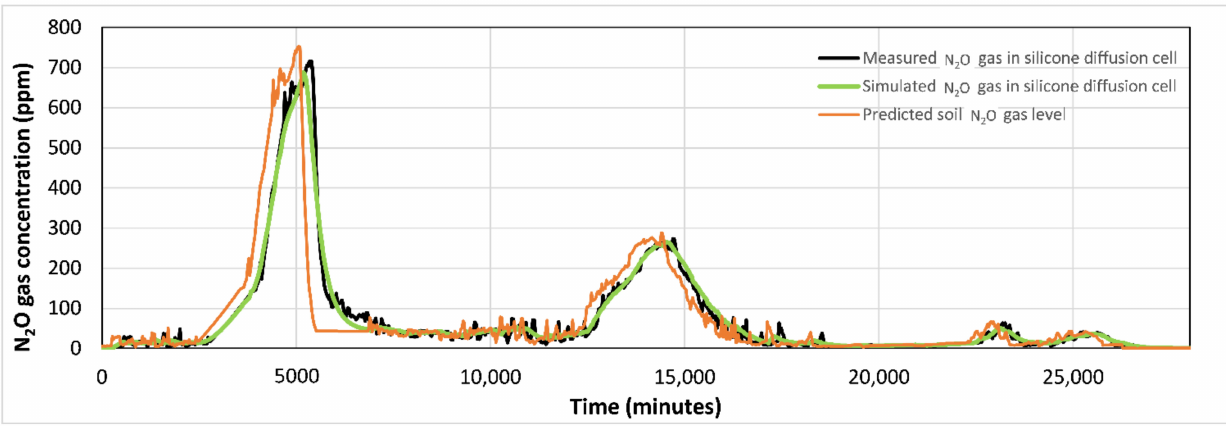
Figure 8. Temporal variations in measured and simulated N 2 O gas levels in the silicone diffusion cell with predicted soil gas levels for experiment 1.